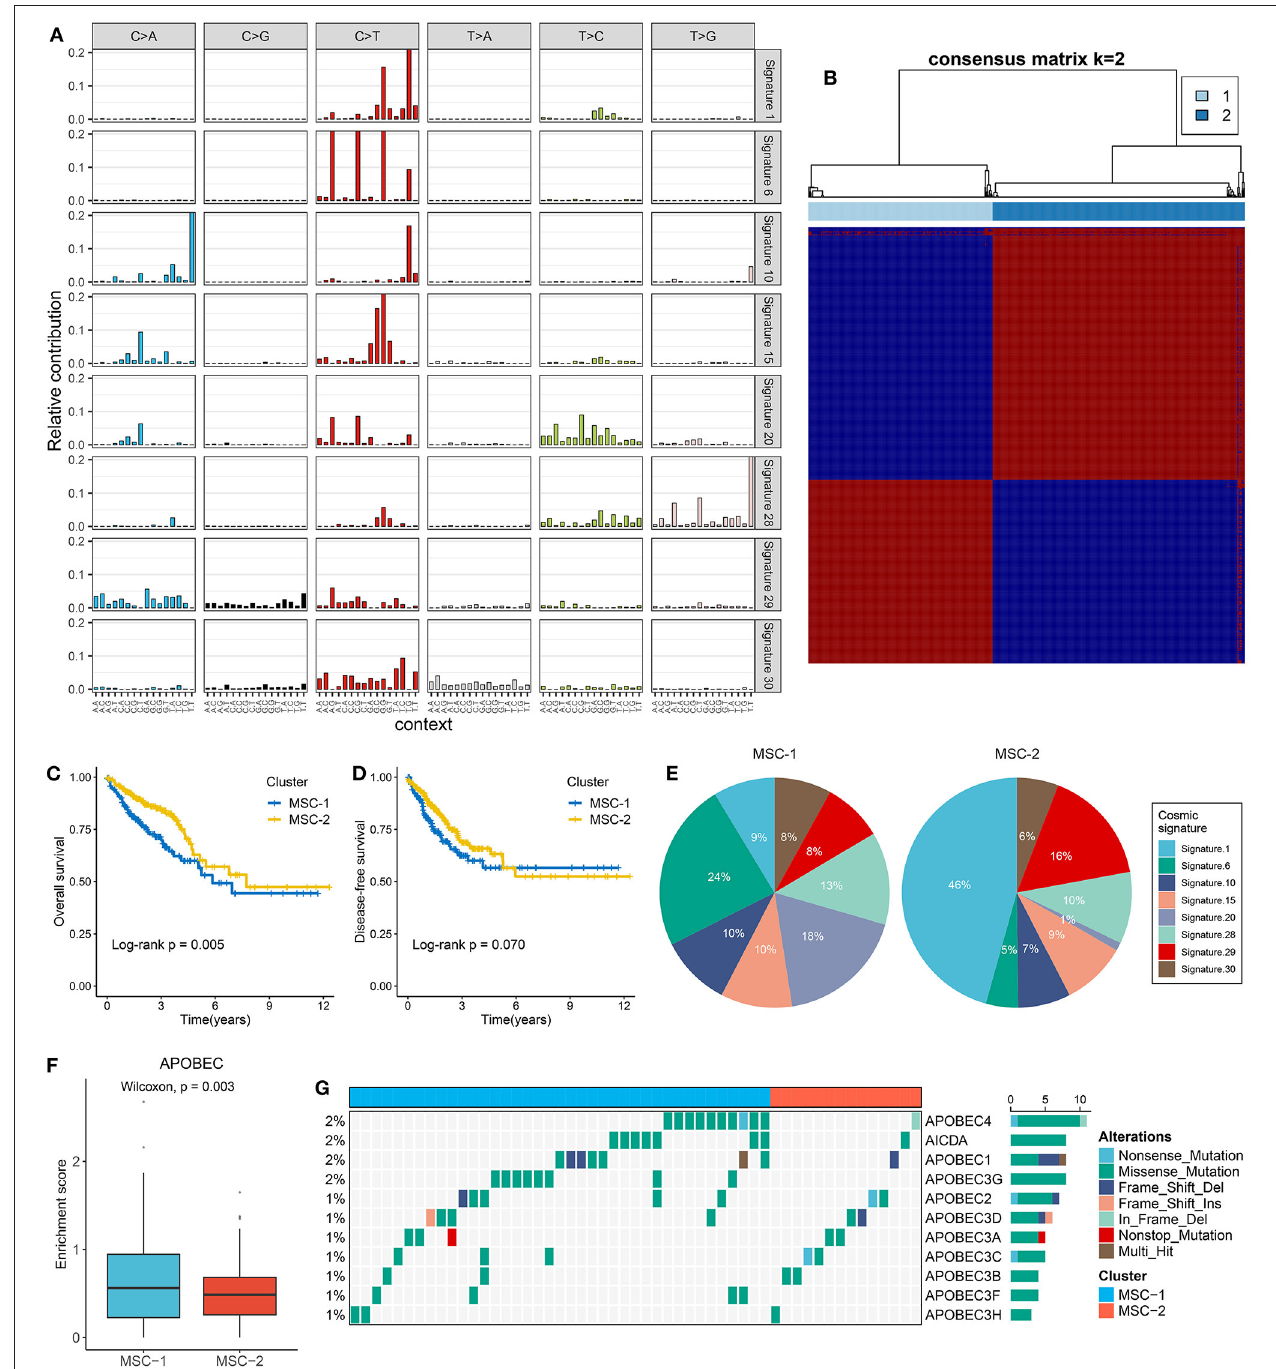
FIGURE 1 | The extraction of mutation signatures and generation of the mutation signature relevant subtypes in CRC. (A) Eight mutation signatures were deciphered (mutation signature 1, 6, 10, 15, 20, 28, 29, and 30) based on NMF algorithm and COSMIC signatures. (B) The consensus score matrix of all samples when k = 2. A higher consensus score between two samples indicates they are more likely to be grouped into the same cluster in different iterations. The rows and columns of heatmap are both samples, and the cell value of the heatmap is the consensus score between two samples. (C,D) Kaplan–Meier analysis for OS (C) and DFS (D) between MSC-1 and MSC-2. (E) Pie charts show the relative proportion of eight categories of mutation patterns in MSC-1 and MSC-2, respectively. (F) The difference of APOBEC enrichment score between MSC-1 and MSC-2. (G) Mutational oncoplot of 11 APOBEC associated genes in two subtypes.